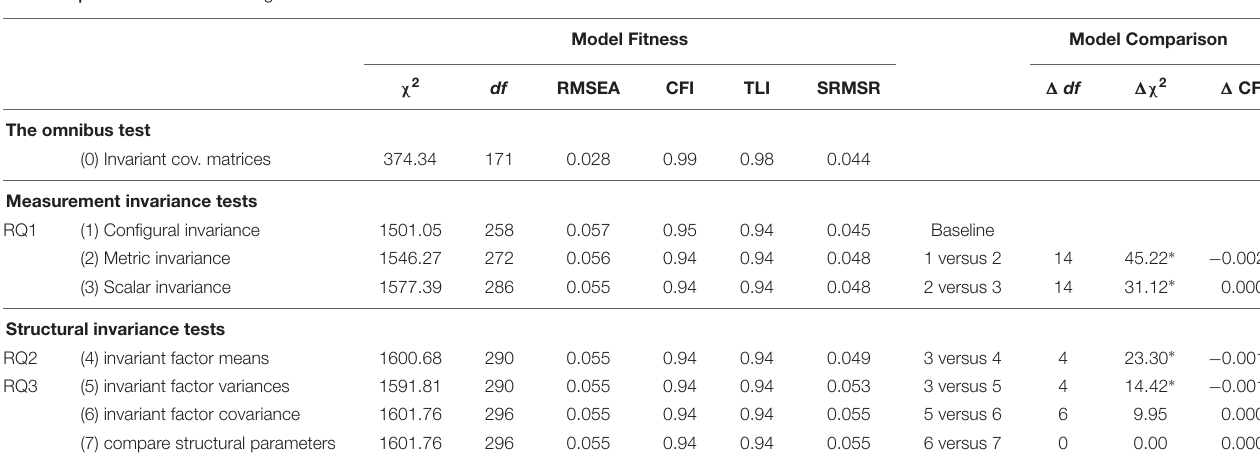
TABLE 4 | Invariance tests across grade